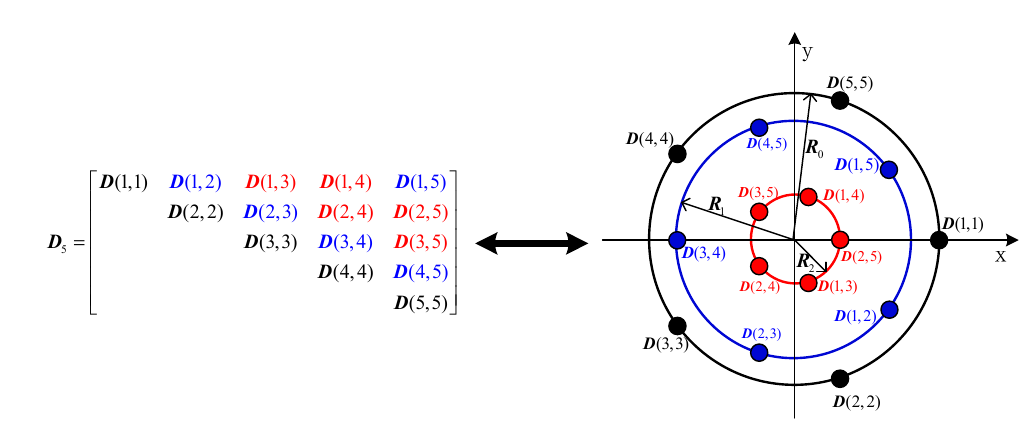
Figure 2. Matrix D 5 and the corresponding virtual array.